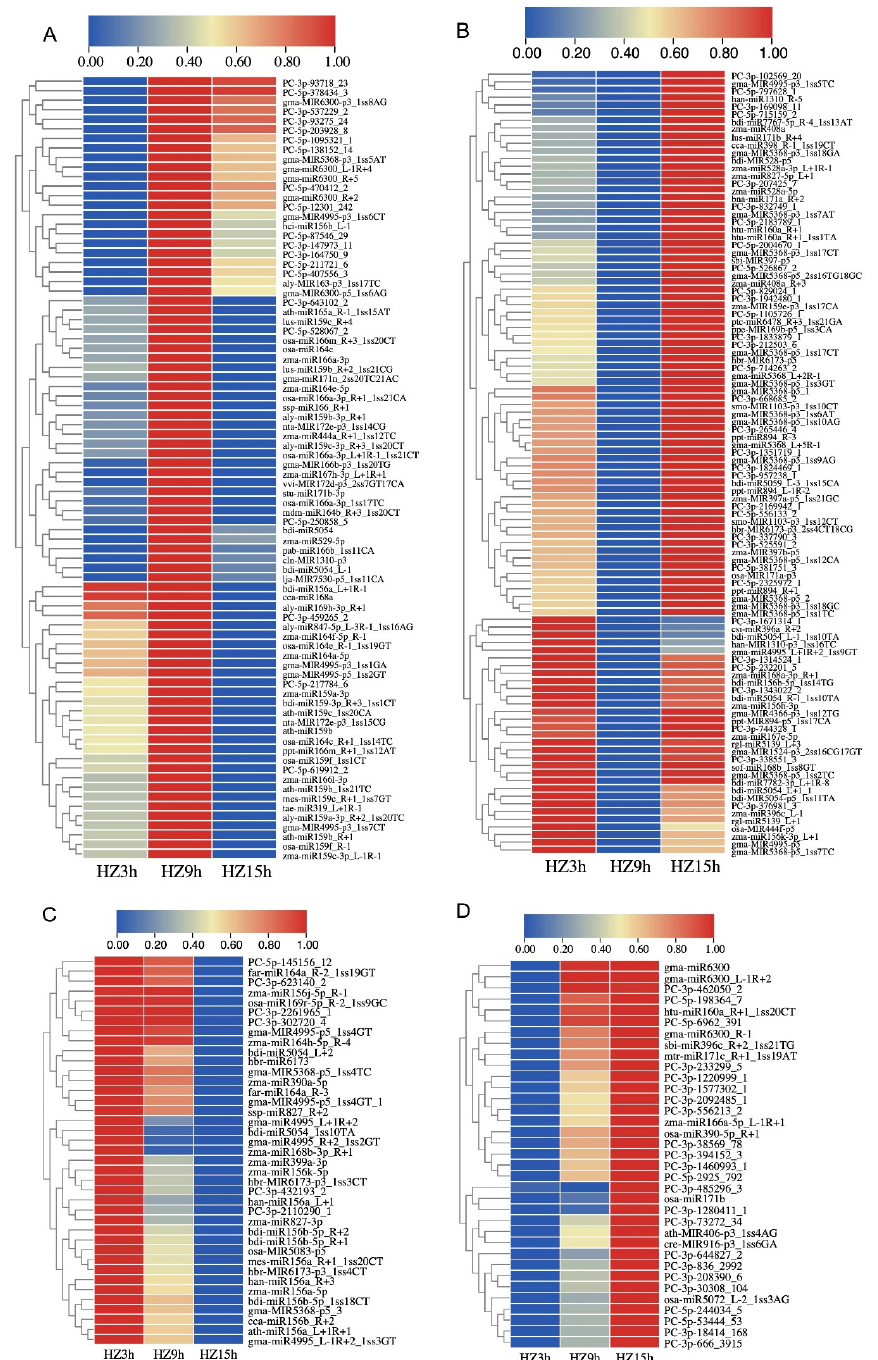
Figure 2. Level of expression of miRNAs in response to C. lunata in the susceptible variety HZ at different inoculation time points (3, 9 and 15 hpi). The expression trends were divided into four categories: first increase and then decrease ( A ), first decrease and then increase ( B ), reduced ex- pression ( C ) and increased expression ( D ).